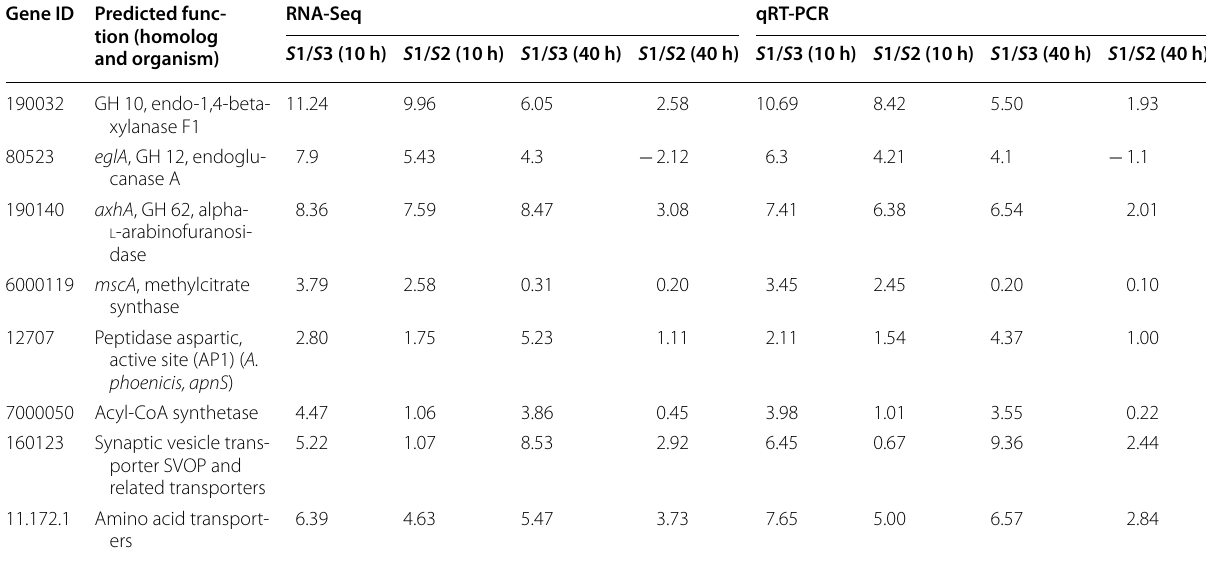
All data were ratio log2 Genes based on a comparison of transcription levels at YX-1217/ATCC 1015 (designated as S 1/ S 3) (10 h), YX-1217/YX-1217G (designated as S 1/ S 2) (10 h), YX-1217/ATCC 1015 (designated as S 1/ S 3) (40 h), and YX-1217/YX-1217G (designated as S 1/ S 2) (40 h), respectively